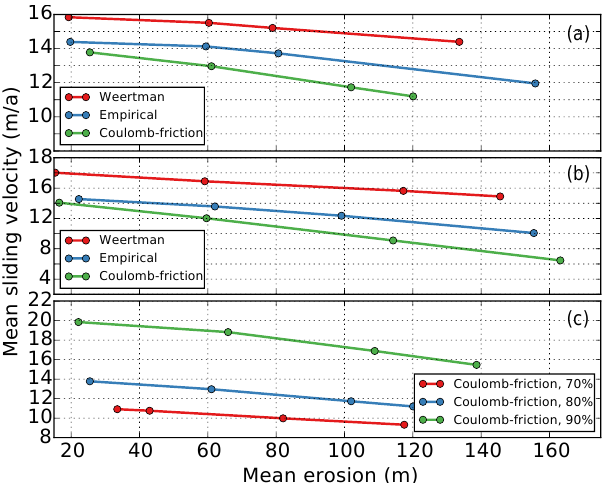
Figure 9. Evolution of mean sliding rate as a function of mean ero- sion. (a) Shows results for three different sliding laws using a non- linear erosion law ( m = 2 in Eq. 9) and 80% floatation. (b) The same as (a) but for m = 1. (c) The evolution of mean sliding for the Coulomb-friction sliding law and three different levels of floata- tion. The means of sliding rate and erosion are computed only for the trunk valley, defined as all glaciated cells below 750m elevation in the initial fluvial